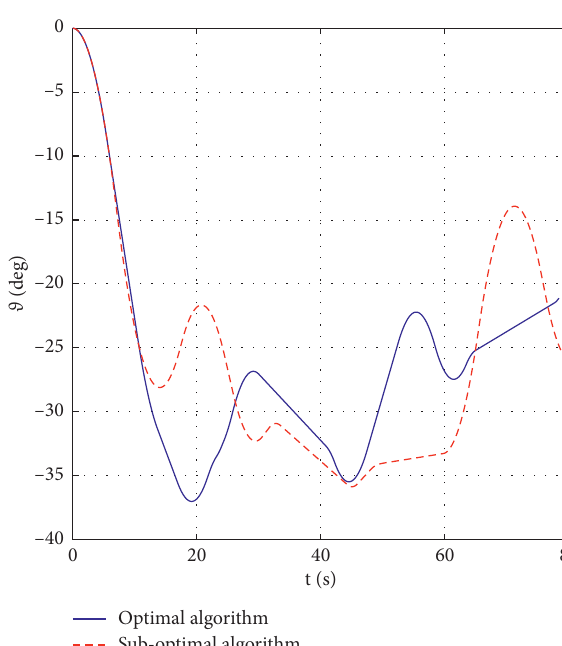
Figure 10: Curve of α and t .